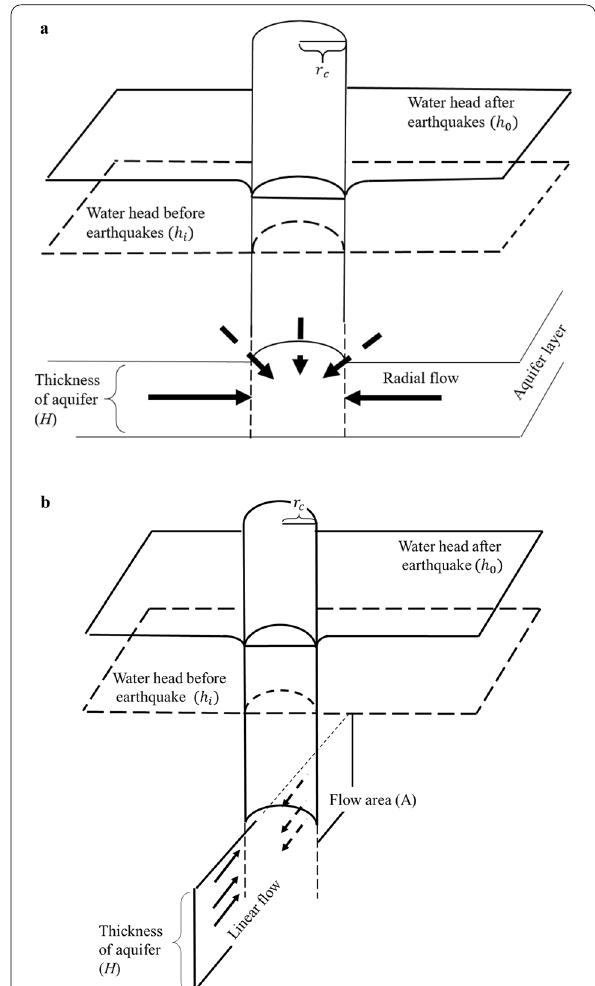
Fig. 6 Slug test model images. The images of slug test models for the radial flow case ( a ) and linear flow case ( b ). The arrows show the flow